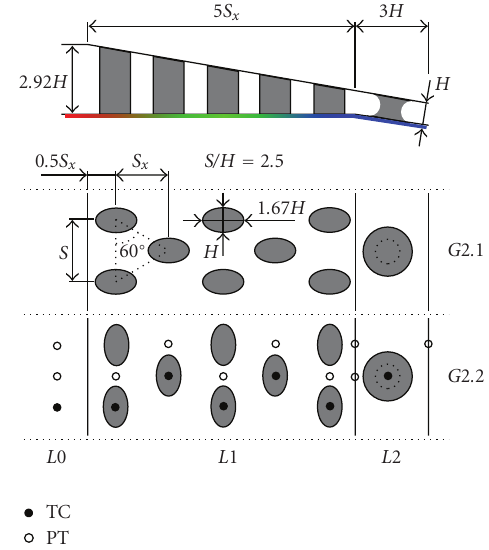
Figure 2: Streamwise and spanwise staggered elliptical pin fin configurations.